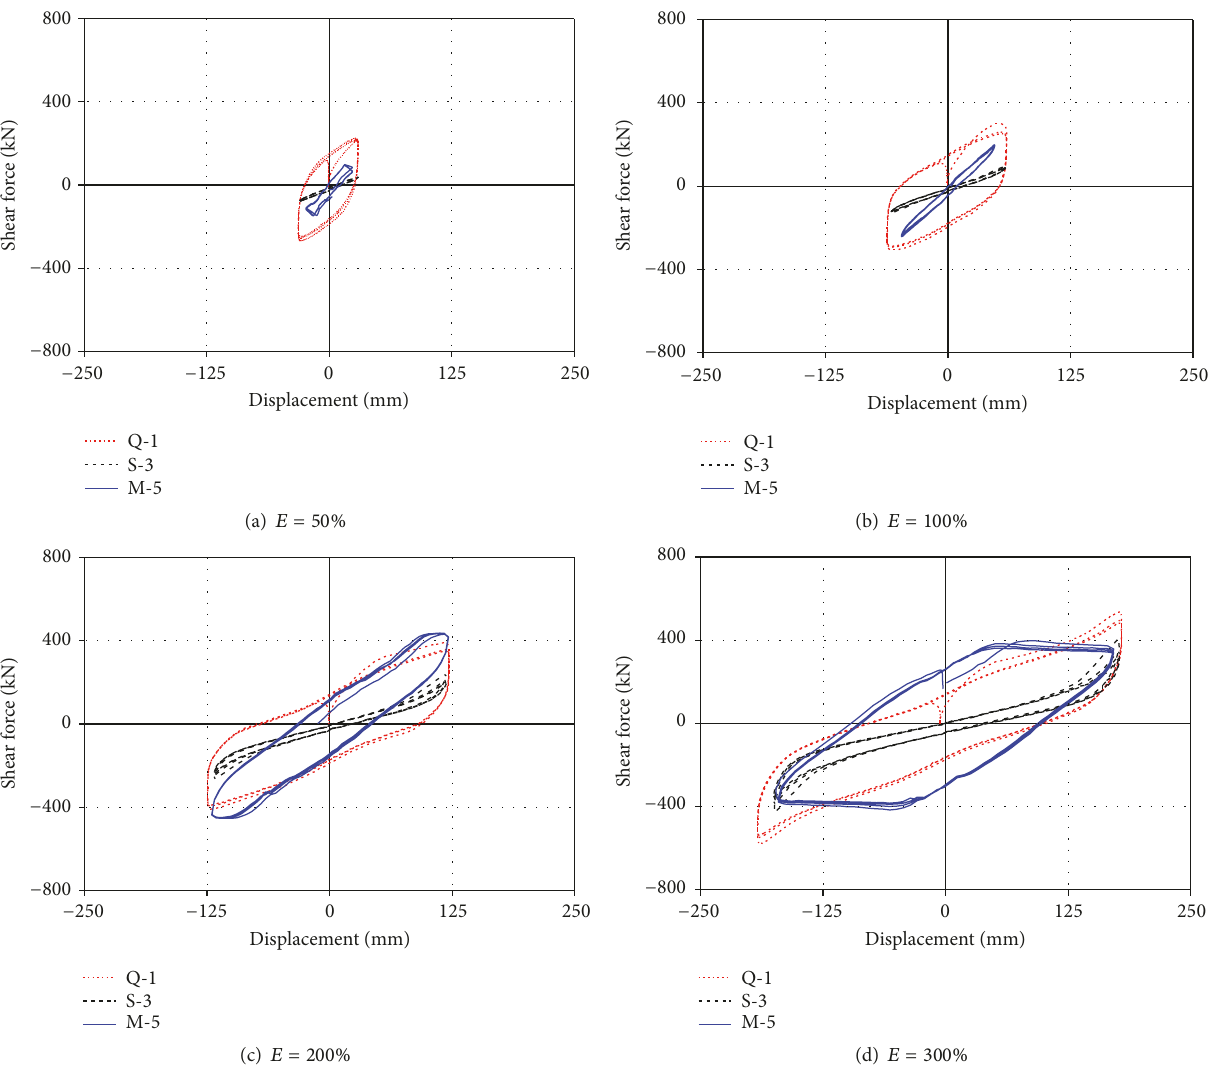
Figure 10: The hysteresis curve of the bearings in different